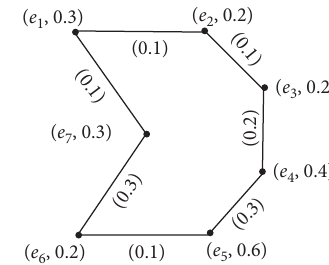
Figure 15: G � ( J , K ) is a fuzzy